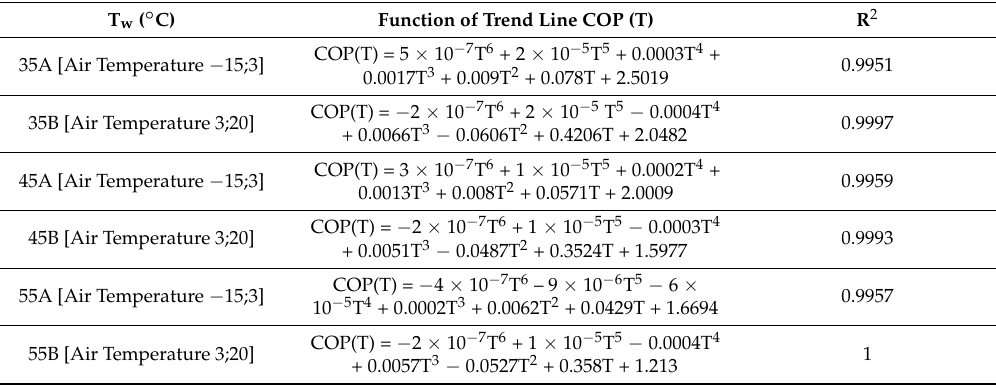
Table 2. Equations of the COP as function of the Air Temperature T (T Aext or T Aout ) and the Water treated Temperature (T w ) at the maximum frequency.